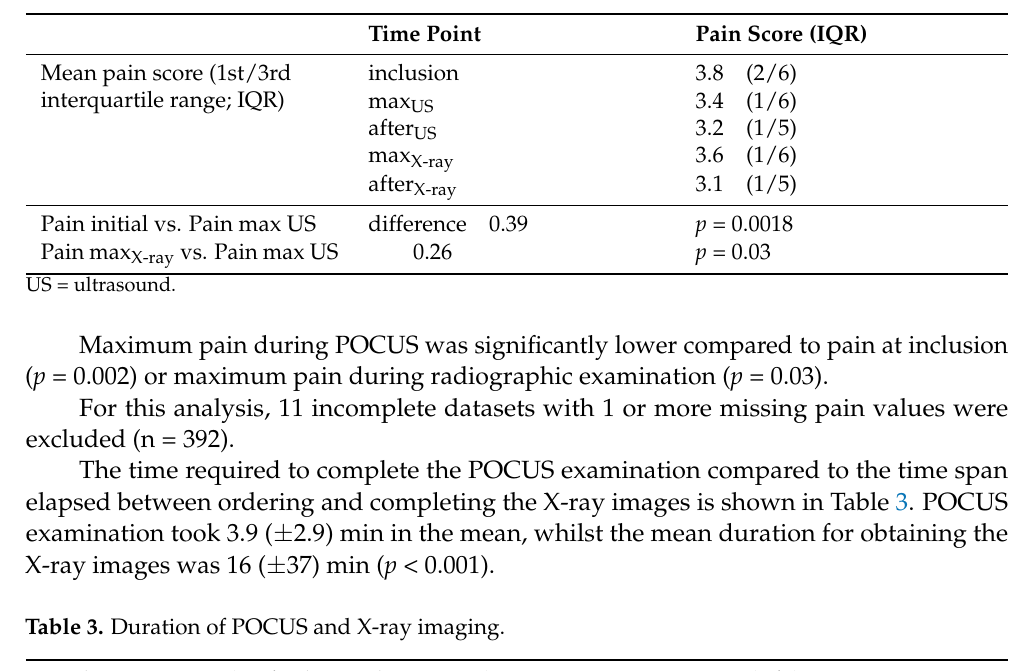
Table 2. Pain levels measured at different time points.